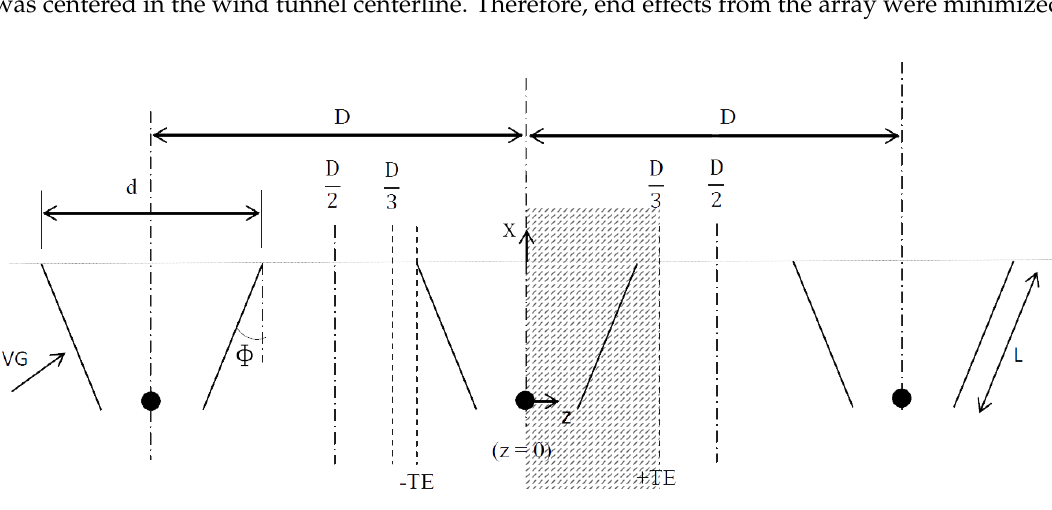
Figure 2. Array layout for experiments shown in [18]. Computational domain width remarked by dash